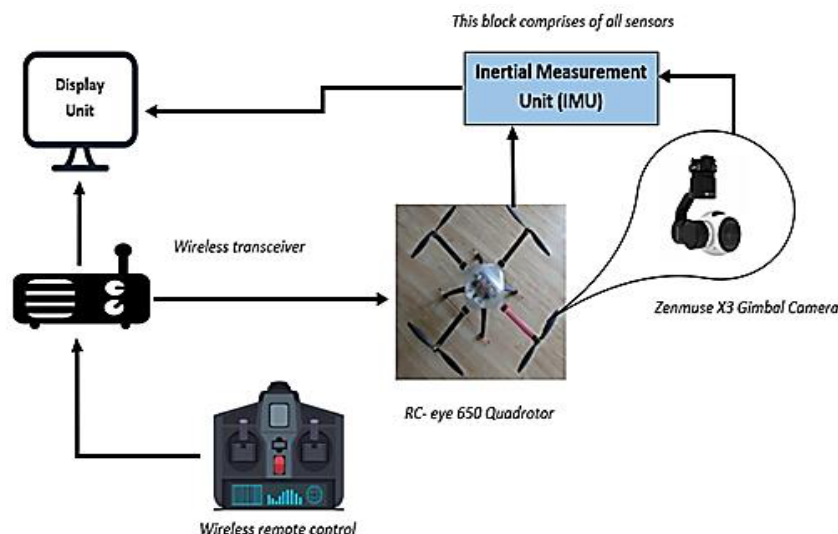
Figure 23. Block diagram demonstrating the experimental setup.